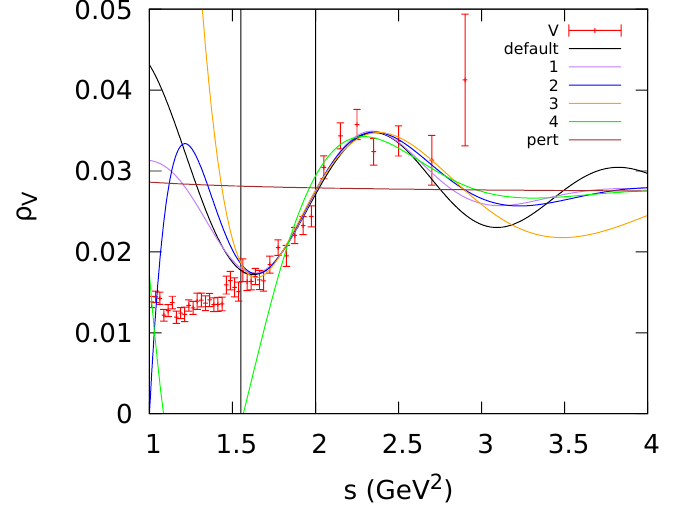
Figure 5 . Comparison of the measured ρ V ( s ) (red data points) with the hypothetical vector spectral functions, obtained with the different model